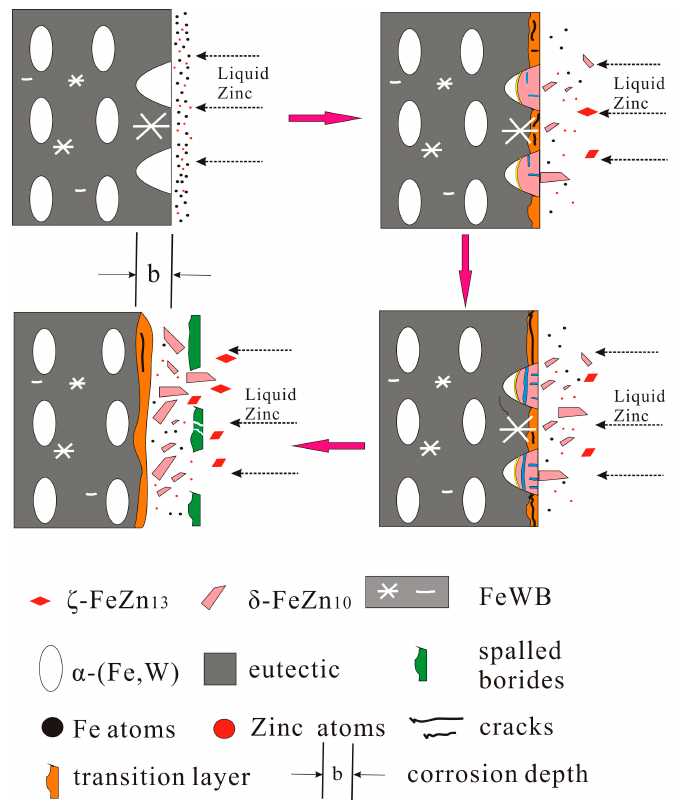
Figure 11. Schematic of corrosion mechanism of cast alloys dipped into liquid zinc.